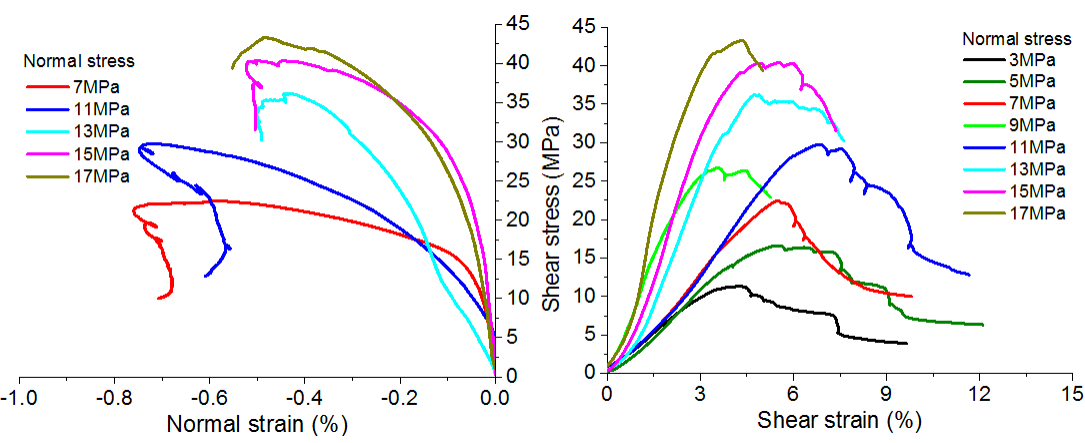
Figure 5. Shear stress-normal strain curves and shear stress-shear strain curves of the granite samples under direct shear experiments.